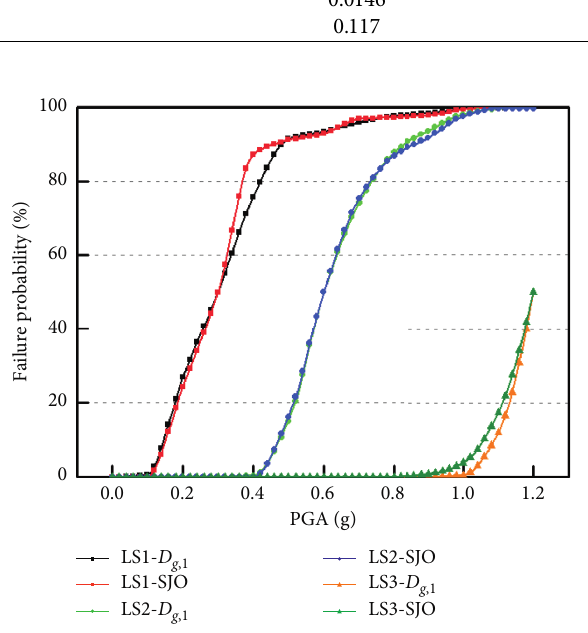
Figure 21: Fragility curves of damage and joint opening